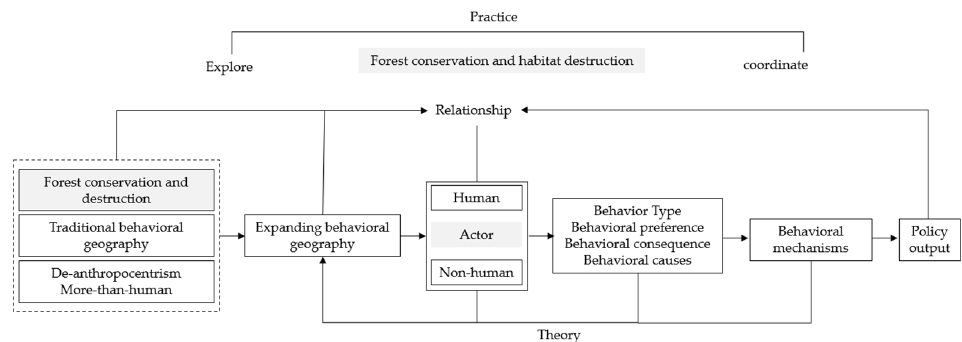
Figure 1. Analysis